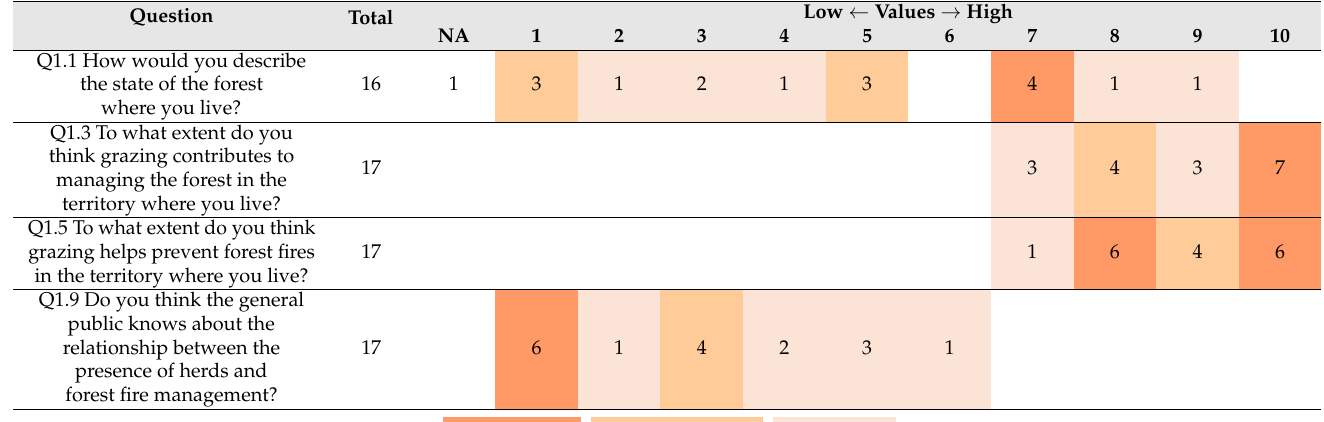
Table 2. Section 1 of the questionnaire—number of responses obtained for each value category. Values for questions on a 1–10 scale (from low to high).